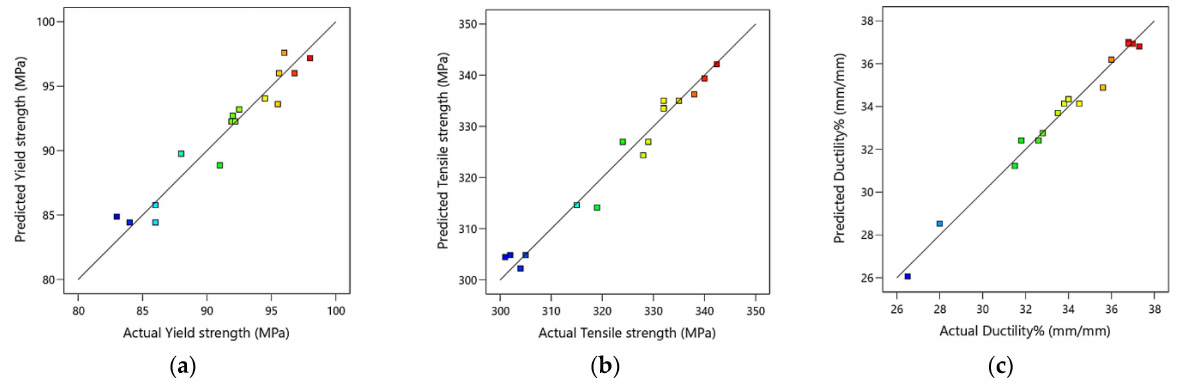
Figure 10. Predicted versus actual values of the ECAP YS ( a ), TS ( b ), and D% ( c ), where the blue points are for minimum output value and gradually changed to red points for maximum output